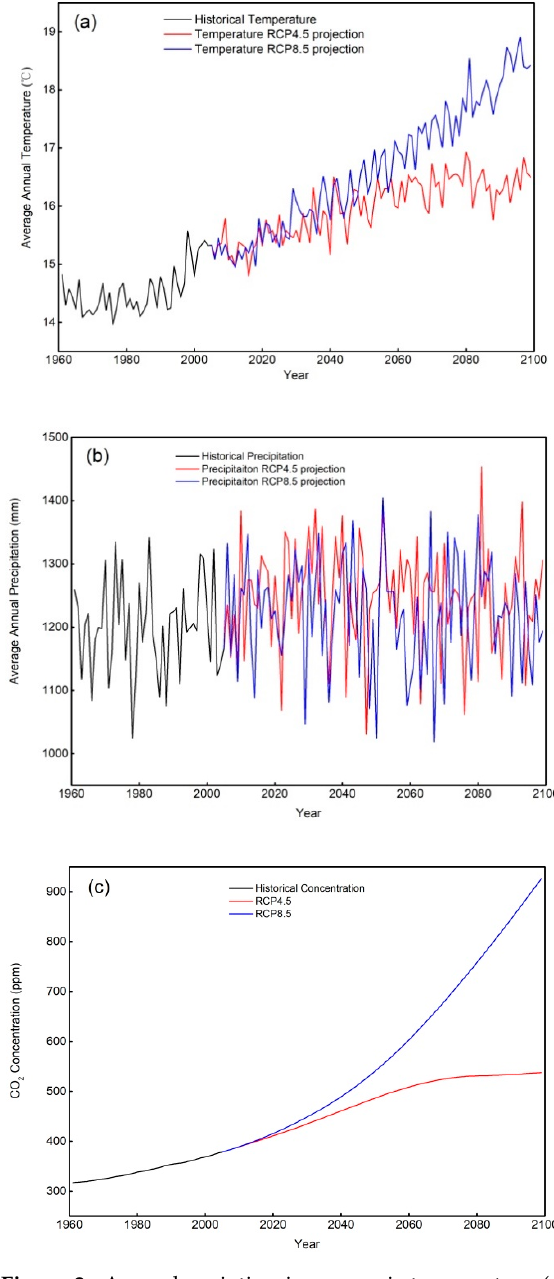
Figure 2. Annual variation in mean air temperature ( a ), precipitation, ( b ) and atmospheric CO 2 concentration ( c ) during the periods 1961–2005/2006–2099 under the RCP4.5 and RCP8.5 scenarios in the YREB.